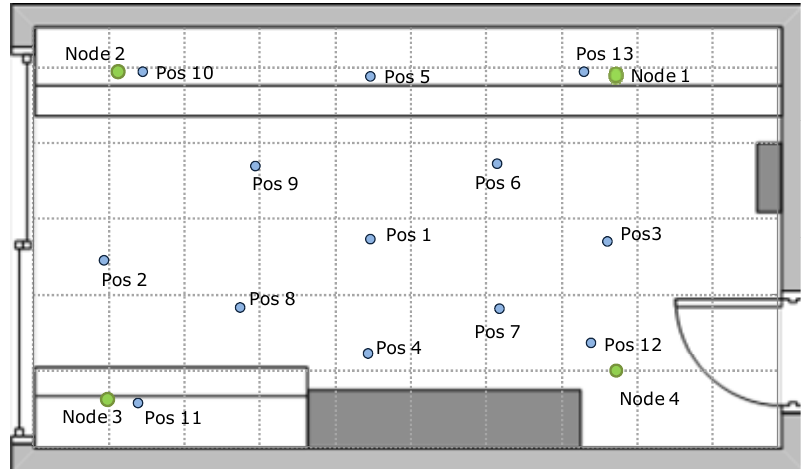
Figure 16. Measurement